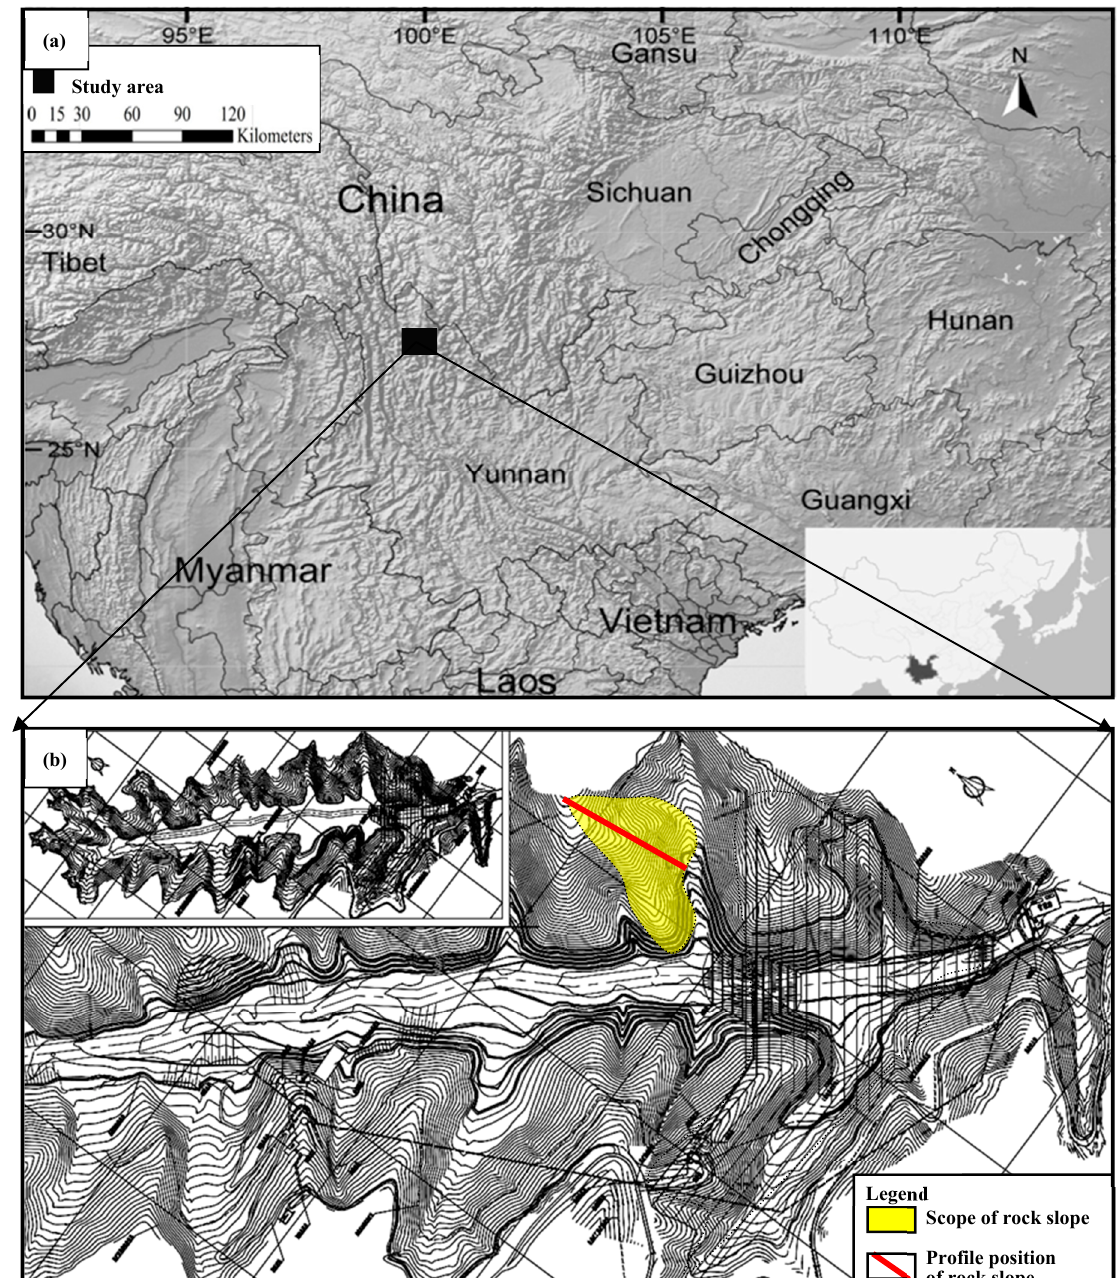
Figure 1. Geographic location of the study area: ( a ) Study area location [6]; ( b ) Rock slope location.